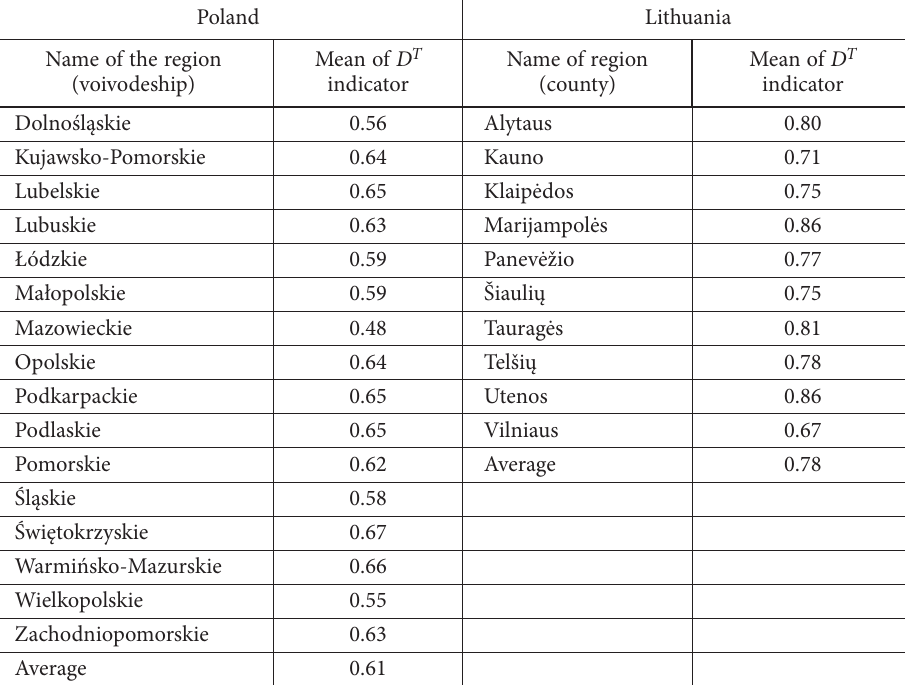
Table 5. The calculation results for economic development in Poland and Lithuania over 2008–2017 (source: compiled by the authors)